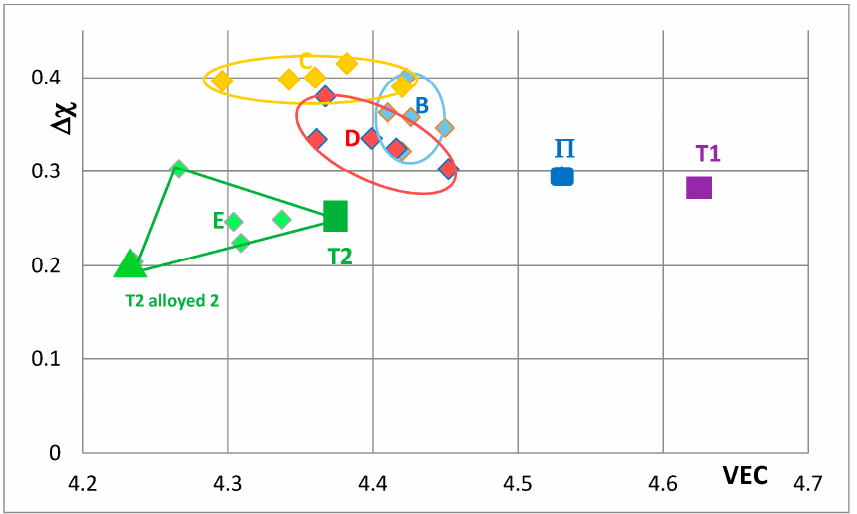
Figure 7. Δχ versus VEC map of unalloyed and alloyed Nb 5 Si 3 , where T1 = Nb 5 Si 3 , Π = (Nb,Ti) 5 Si 3 , T2 = Nb 5 (Si,B) 3 , T2 alloyed2 = (Nb,Ti,Cr,Hf) 5 (Si,Al,B) 3 , area B = (Nb,Ti,Cr) 5 (Si,Al) 3 , area C = (Nb,Ti,Cr) 5 (Si,Al,Ge) 3 , area D = (Nb,Ti,Cr) 5 (Si,Al,Sn) 3 and area E = (Nb,Ti,Cr) 5 (Si,Al,B) 3 . The data is from KZ5 type alloys with nominal compositions Nb-24Ti-18Si-5Al-5Cr + 5X, where X = B, Ge, Sn. Average positions in areas B to E are indicated by data point closest to letter (see text). For the compositions of Π , T2 and T2 alloyed2 see text.